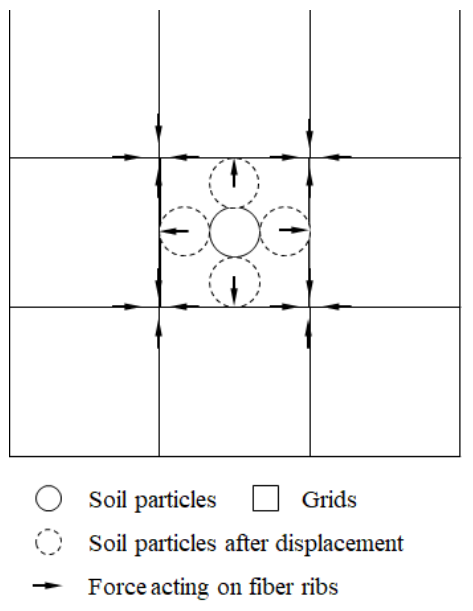
Figure 9. Schematic diagram of the grid interlocking effect.